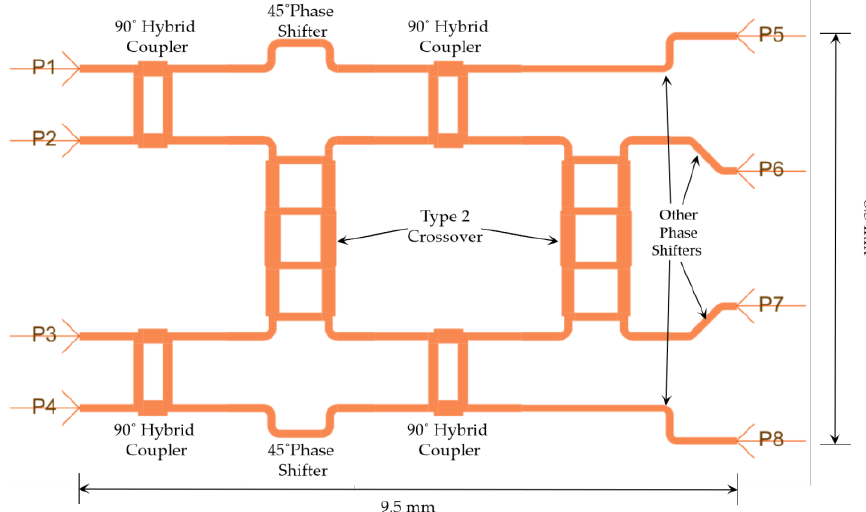
Figure 14. Layout of the 4 × 4 Butler matrix in ADS.